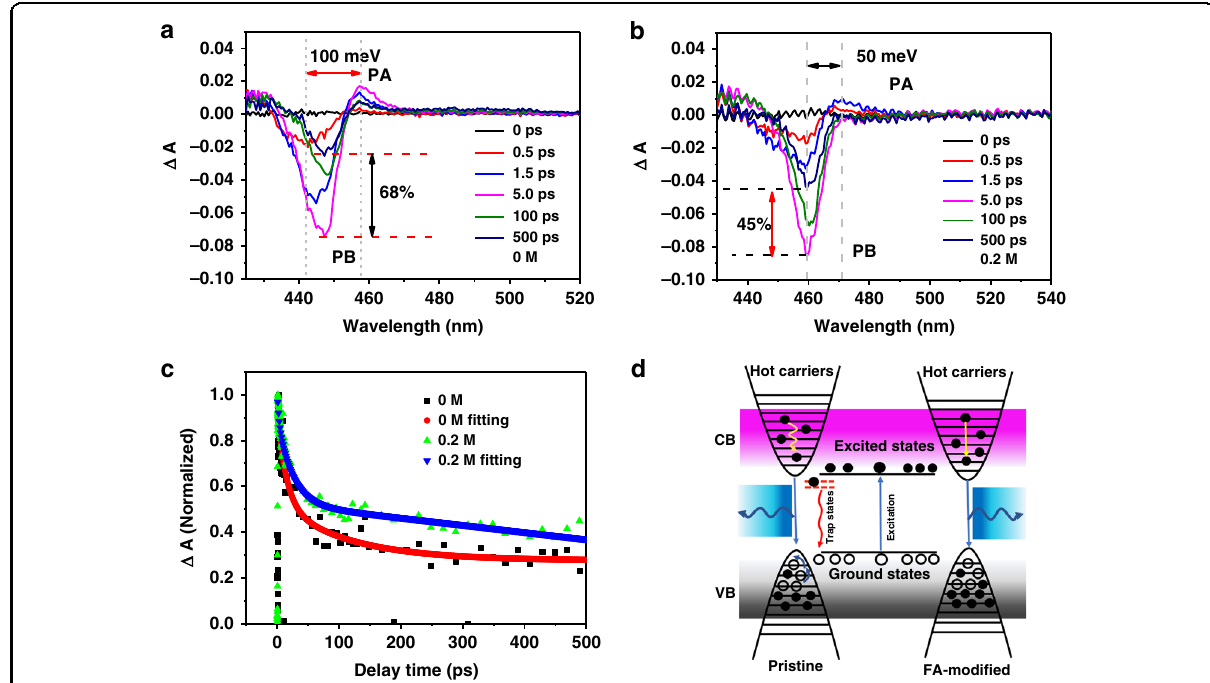
Fig. 4 The carrier recombination dynamic of QDs. Femtosecond transient absorption spectroscopy under 400 nm pump pulse of a CsPb(Cl 0.5 Br 0.5 ) 3 QDs and b 0.2 M FA-doped CsPb(Cl 0.5 Br 0.5 ) 3 QDs; c the comparison of bleaching recovery kinetics of two samples ( λ ex = 400 nm) monitored at their bleaching maximum value; d the mechanism of carrier relaxation for excitation above the